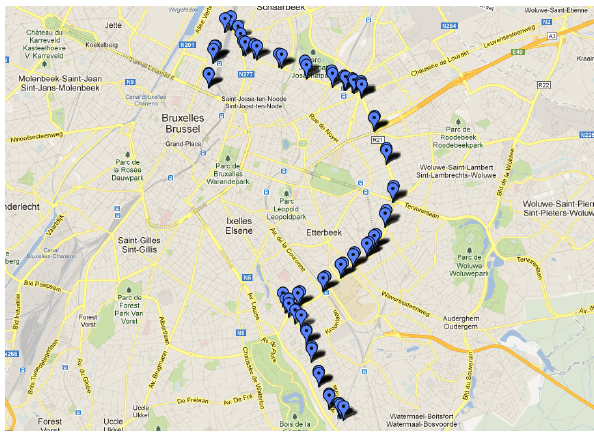
Figure 6. Stops of Tram